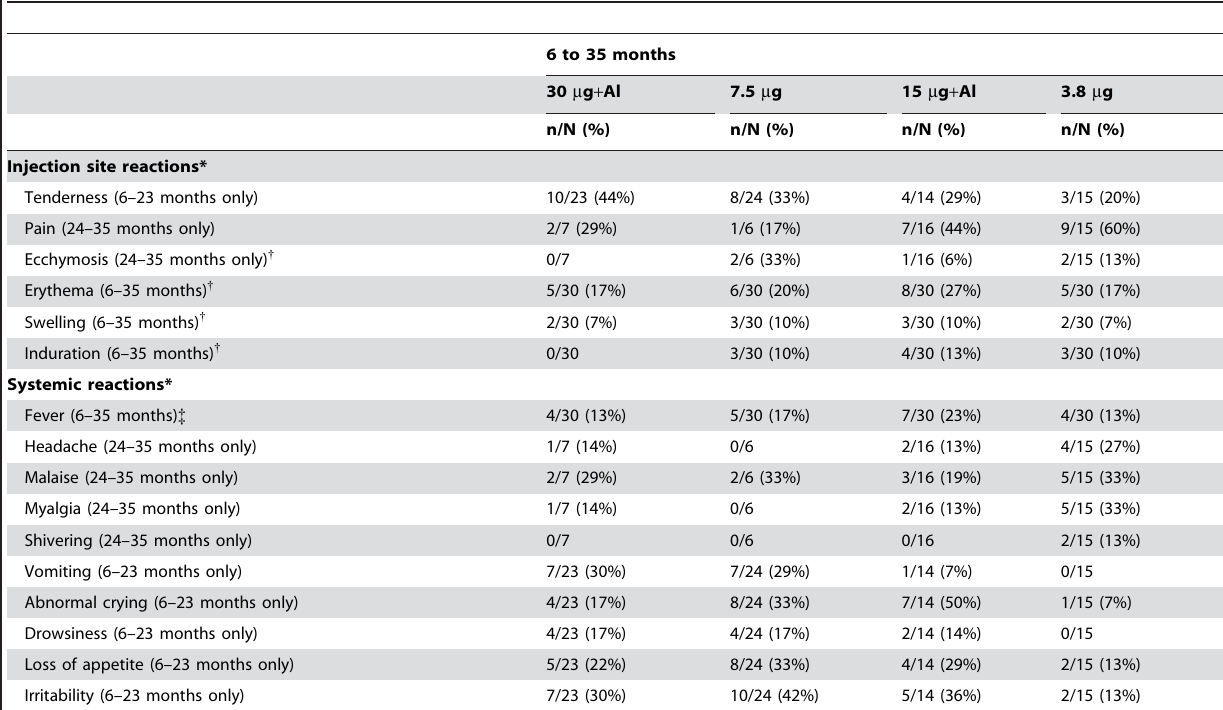
Table 3. Reactogenicity within 7 days after first vaccination in children aged 6–35 months: number and proportion subjects per age and vaccine group experiencing each solicited reaction at least once during period Day 0–7.